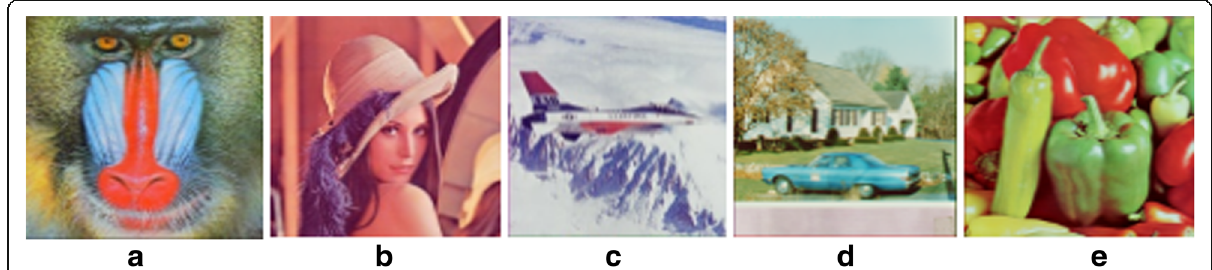
Fig. 9 Standard benchmark images. a Baboon. b Lena. c Airplane. d Car. e